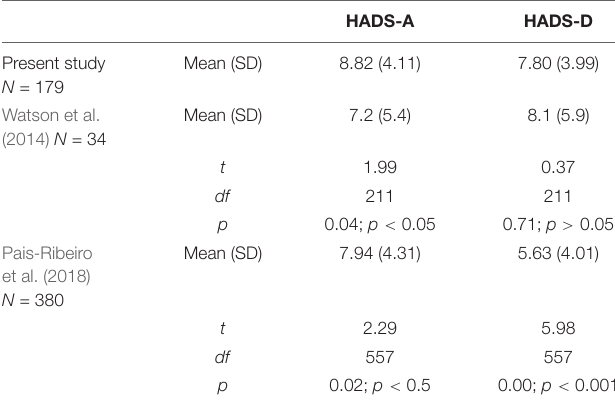
value of < 0.05 indicates a “close fit,” and that < 0.08 suggests a reasonable model–data fit (e.g., Browne and Cudeck, 1993; Jöreskog and Sörbom,